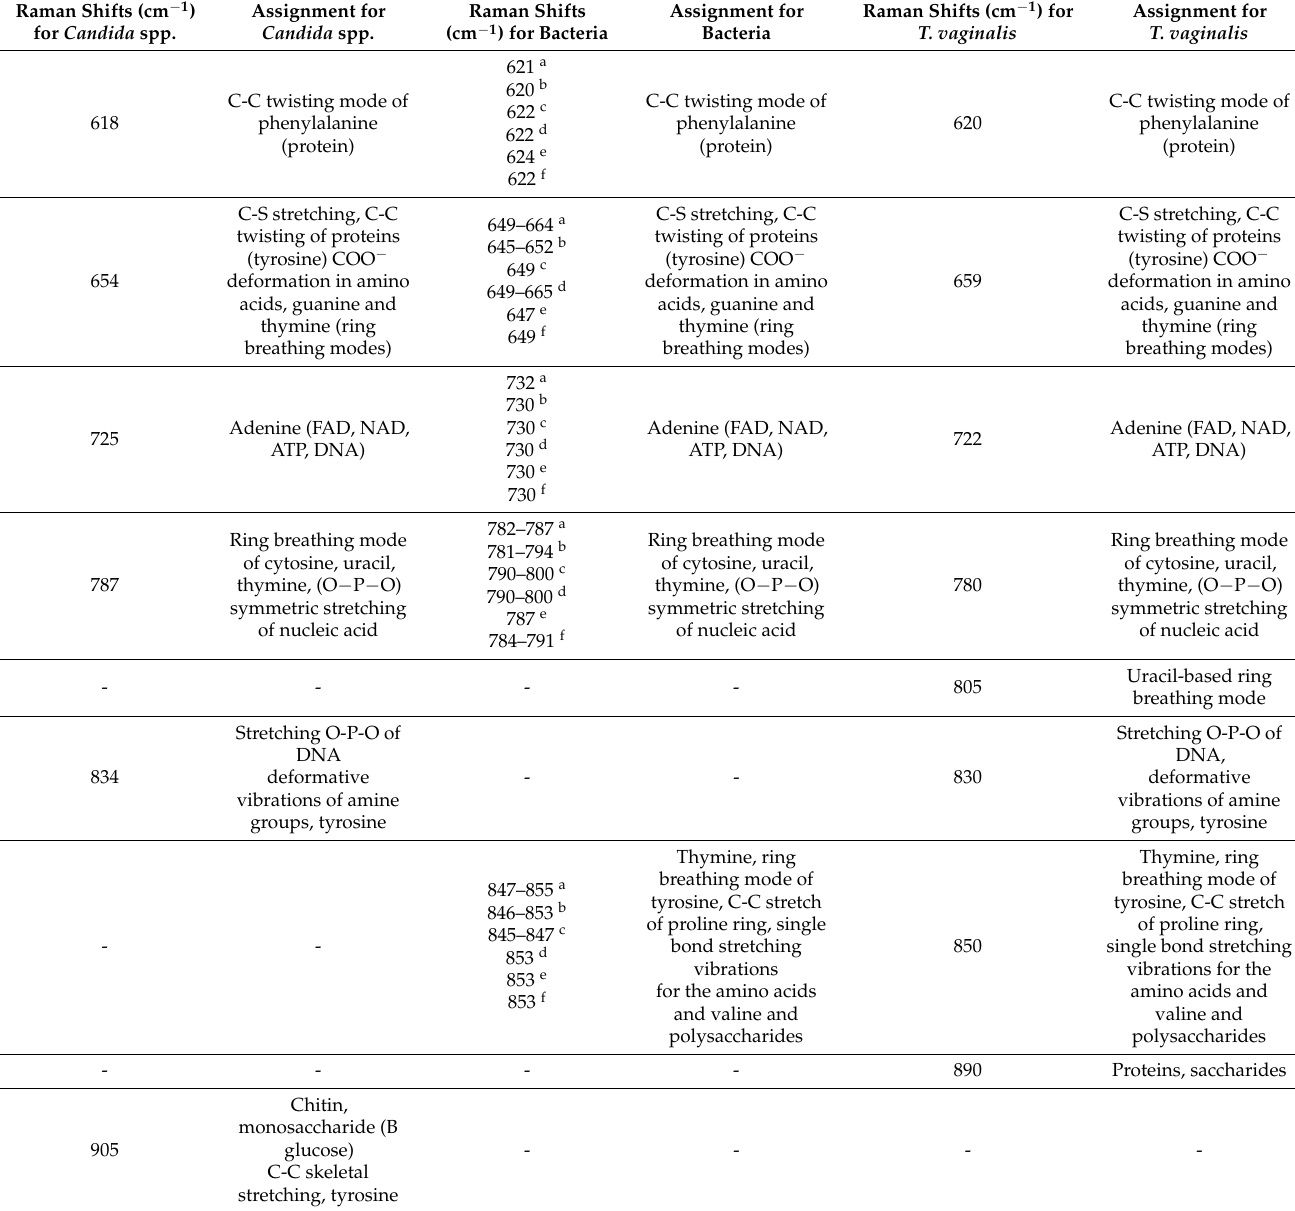
Table 1. The tentative assignments for the most prominent bands of bacteria, Candida spp. and Trichomonas vaginalis analyzed in the present study. Compounds typical for a specific group of microorganisms are bolded. Ranges of spectral bands of different bacteria species are distinguished by symbols: a for Lactobacillus spp., b for Bifidobacterium spp., c for pathogens grown in MRS agar, d for pathogens on RCM agar, e for pathogens on TSA agar, and f for pathogens on chocolate agar. Raman Shifts (cm − 1 ) for Candida